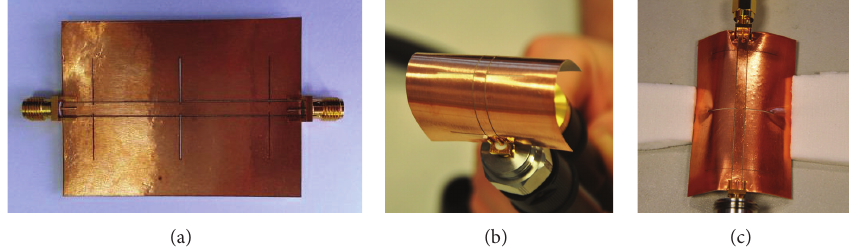
Figure 13: Photographs of the fabricated filter: (a) planar version, (b) curved along its length, and (c) curved along its width.